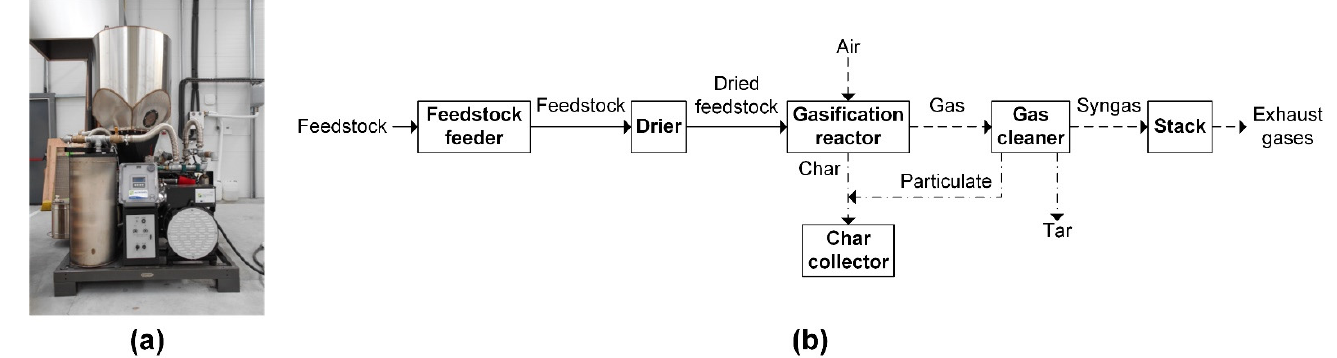
Figure 2. Downdraft gasifier used in the experiments: ( a ) image of the equipment; ( b ) block dia- gram.